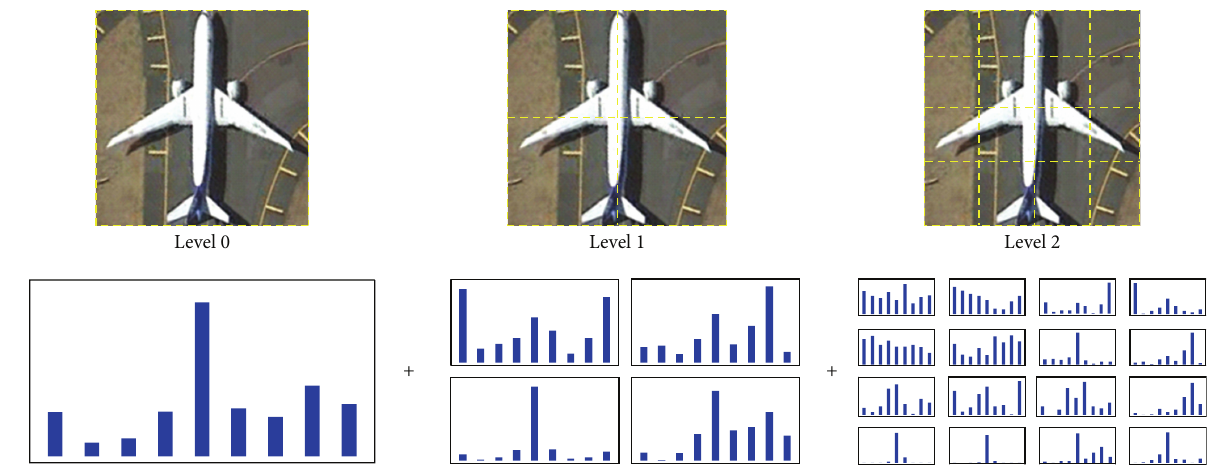
Figure 4: Multilevel feature